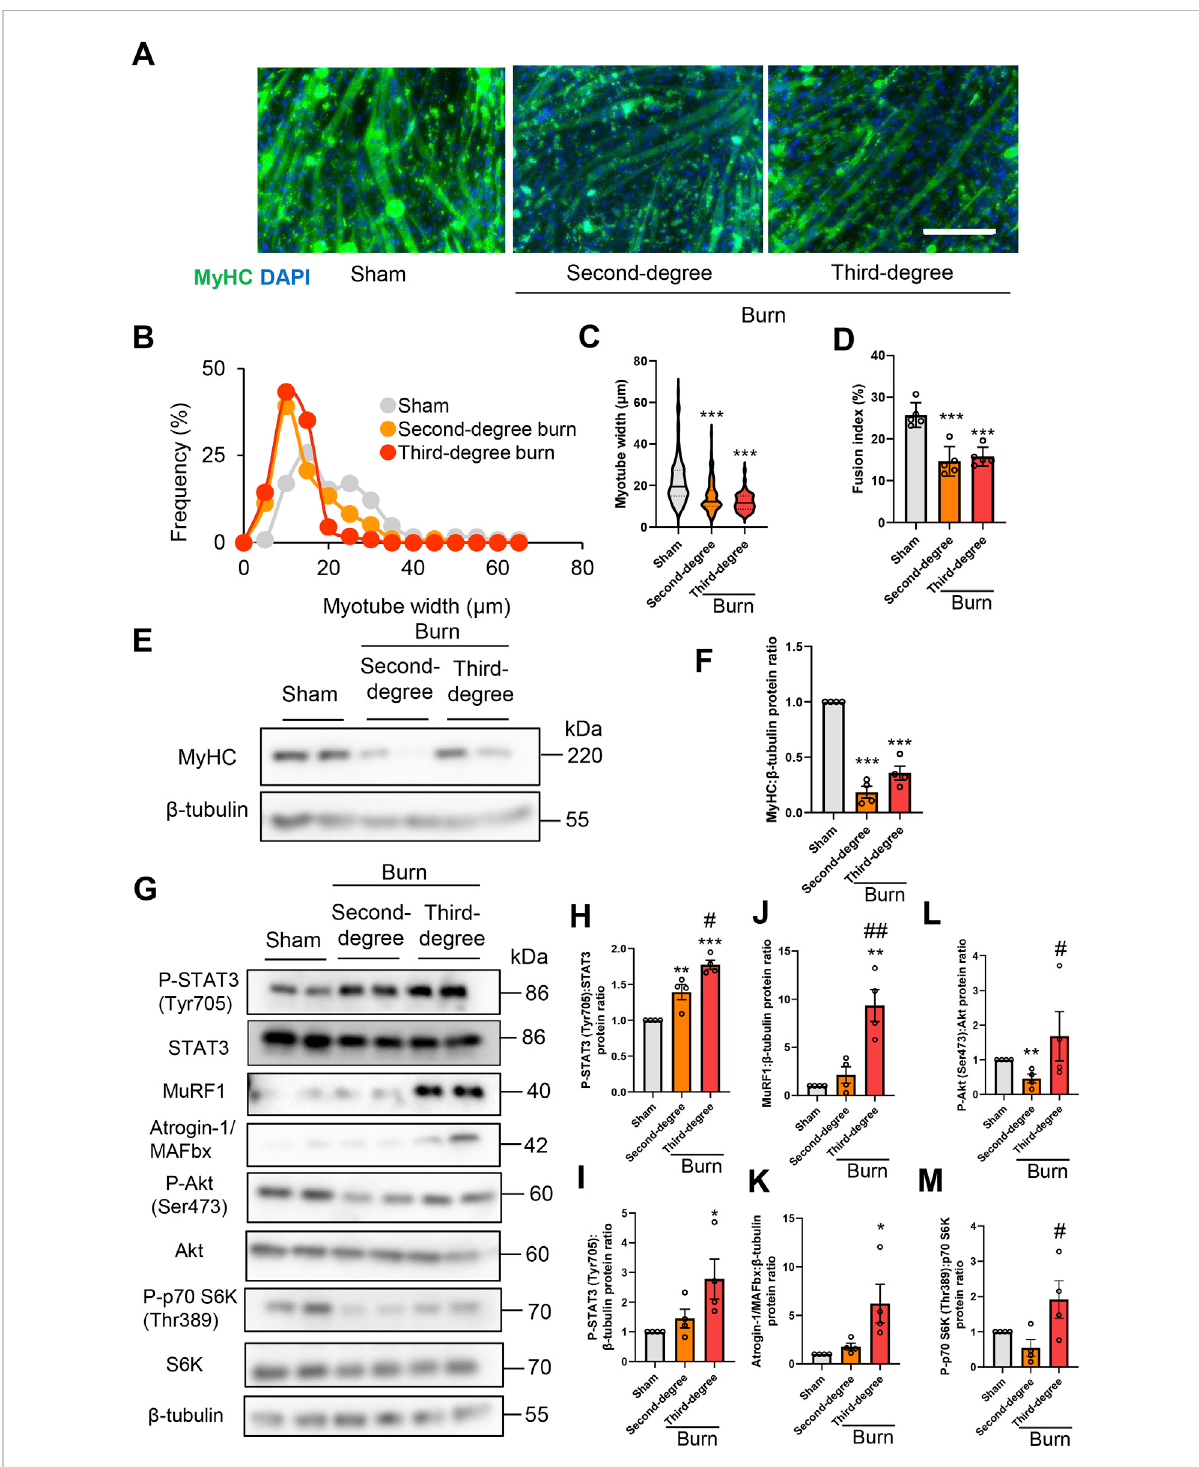
FIGURE 3 Plasma from burned mice induces the atrophy of C2C12 myotubes. C2C12 myotubes were incubated with plasma collected from burn or sham-burnmice(5%vol/vol)for24or48 h.Representativeimmuno fl uorescencestainingofMyHCinC2C12myotubes (A) treatedwithplasmafrom burn or sham-burn mice for 48 h. Scale bar = 100 µm. Distribution of myotube widths (B) , violin plot of myotube width (C) , and fusion index (D) . N = 97 – 124/group. The continuouslinesand dotted lineswithin theviolinplotindicatethemedian andquartiles,respectively. Thefusionindexwas calculatedfrom fi verandomlyselected fi elds.Westernblotanalysis (E) andquanti fi cation (F) ofMyHCexpressioninC2C12myotubestreatedfor48 h withplasmafromburnorsham-burnmice.Datain (F) werenormalizedto β -tubulinproteinlevels,andtheratioinshamcontrolcellswassetas1.N=